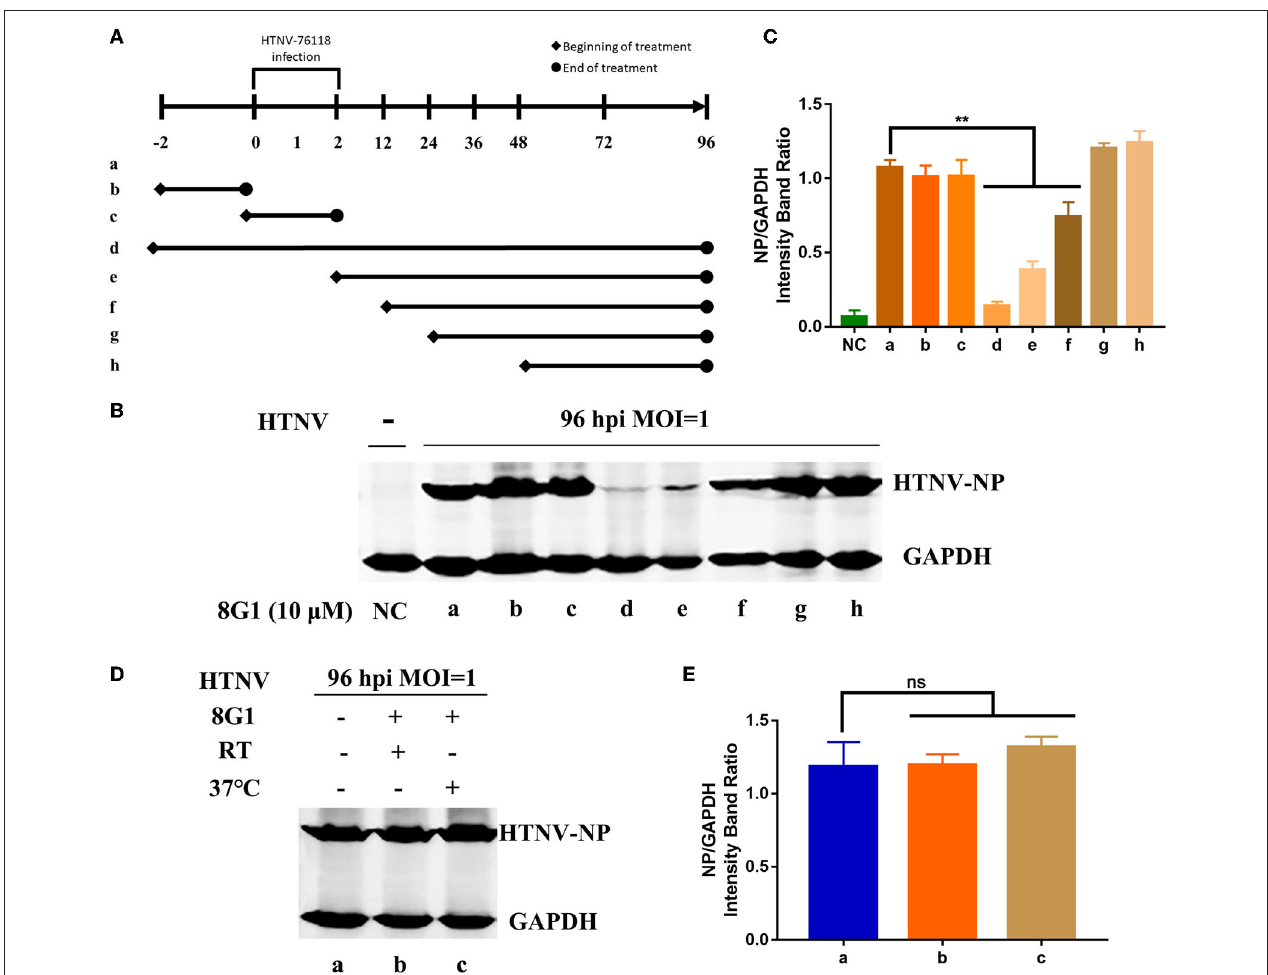
FIGURE 5 | Compound 8G1 reduced the expression of HTNV-NP proteins at the early stage of HTNV infection. (A) Different administration regimens of compound 8G1 treated the HTNV-infected A549 cells at an MOI of 1.0. Lane a: without compound 8G1 treatment; lane b: compound 8G1 treatment for 2h pre-infection; lane c: compound 8G1 treatment for 2h post-infection (hpi); lane d–h: treatment continues from 2h pre-infection, 2, 12, 24, and 48 hpi to the 96 hpi time point. (B) The representative Western blot staining for HTNV NP protein in the groups with different administration regimens of compound 8G1. (C) The analyzed result of the expression of HTNV-NP protein in groups with different administration regimens of compound 8G1. ** p < 0.01 vs. a, n = 3. (D) The representative Western blot staining for HTNV NP protein in the A549 cells without or in the presence of compound 8G1 at different temperatures. (E) The analyzed result of the expression of HTNV NP protein in control or compound 8G1 treatment groups at room temperature (RT) or 37 ◦